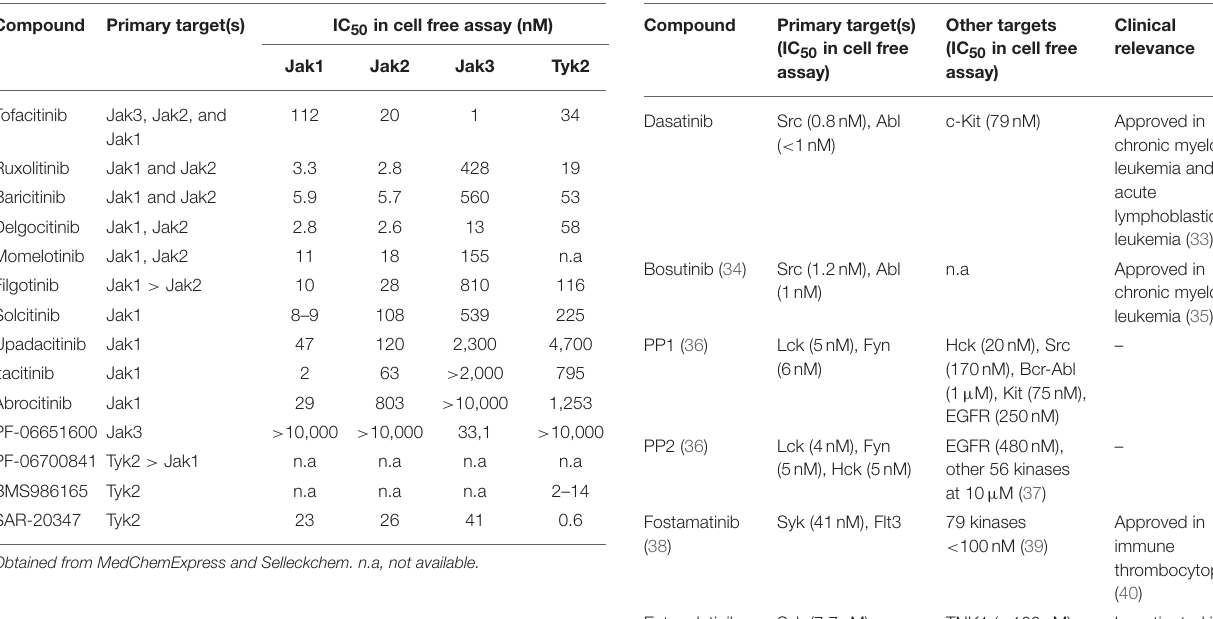
TABLE 2 | Inhibitors of the Src-family and